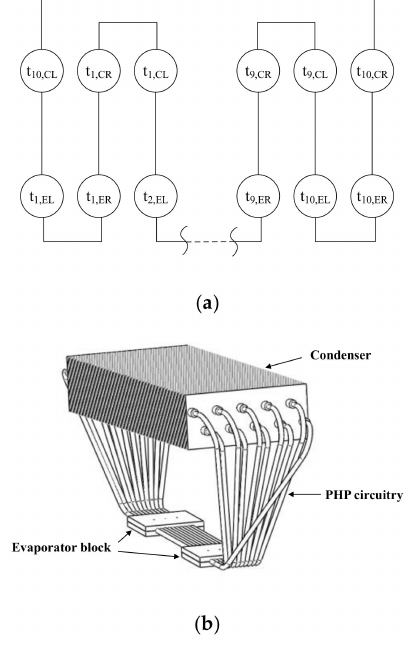
Figure 7. Schematic of ( a ) pipe connection ( b ) PHP thermal